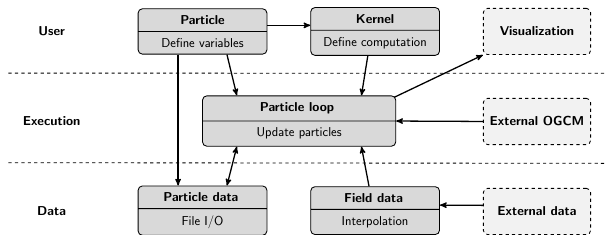
Figure 1. Conceptual abstractions (dark) and functionalities encap- sulated in the Parcels prototype in relation to external components